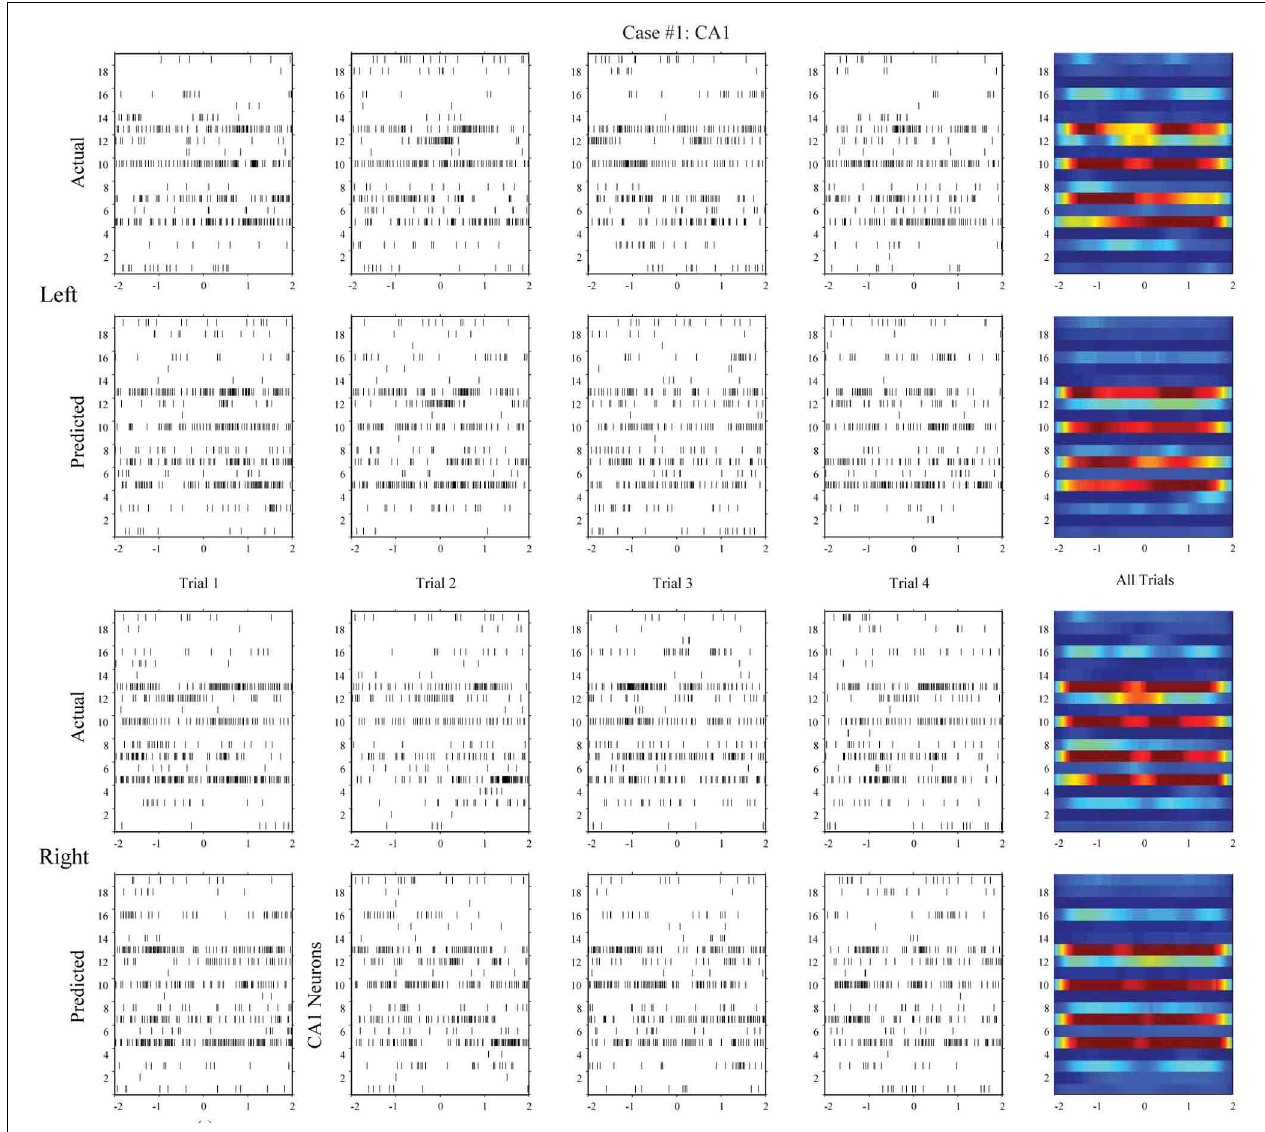
FIGURE 6 | Spatio-temporal patterns of spikes in the hippocampal CA1 (output) region during left and right events of the DNMS. For each position, the top row shows the actual CA1 spatio-temporal